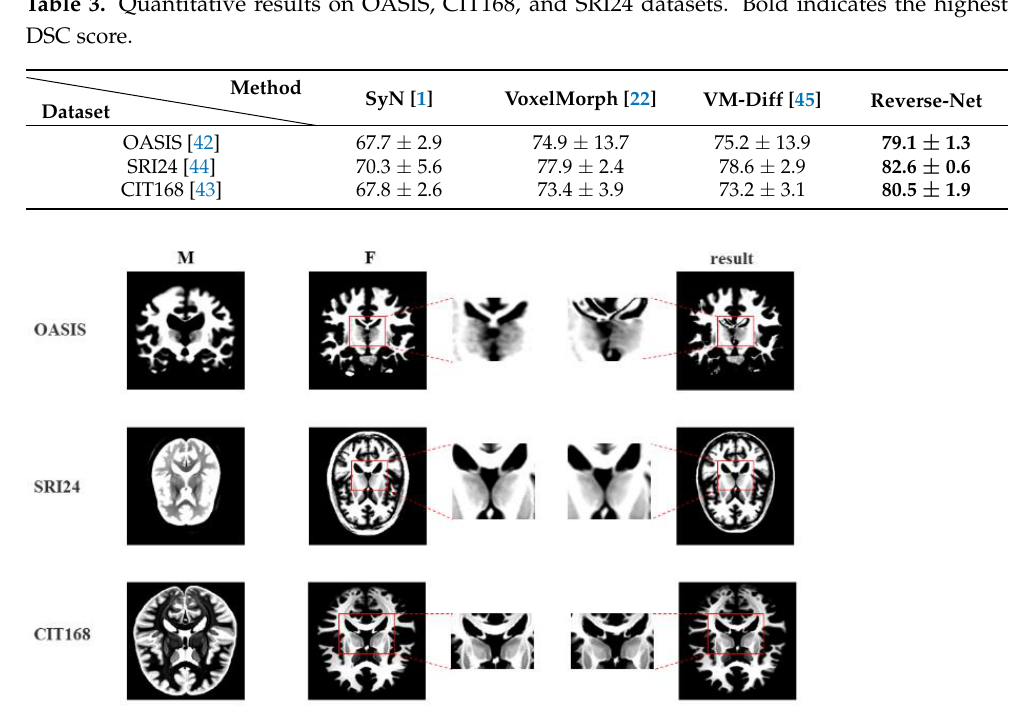
Figure 11. Experimental results on CIT168, SRI24, and OASIS.